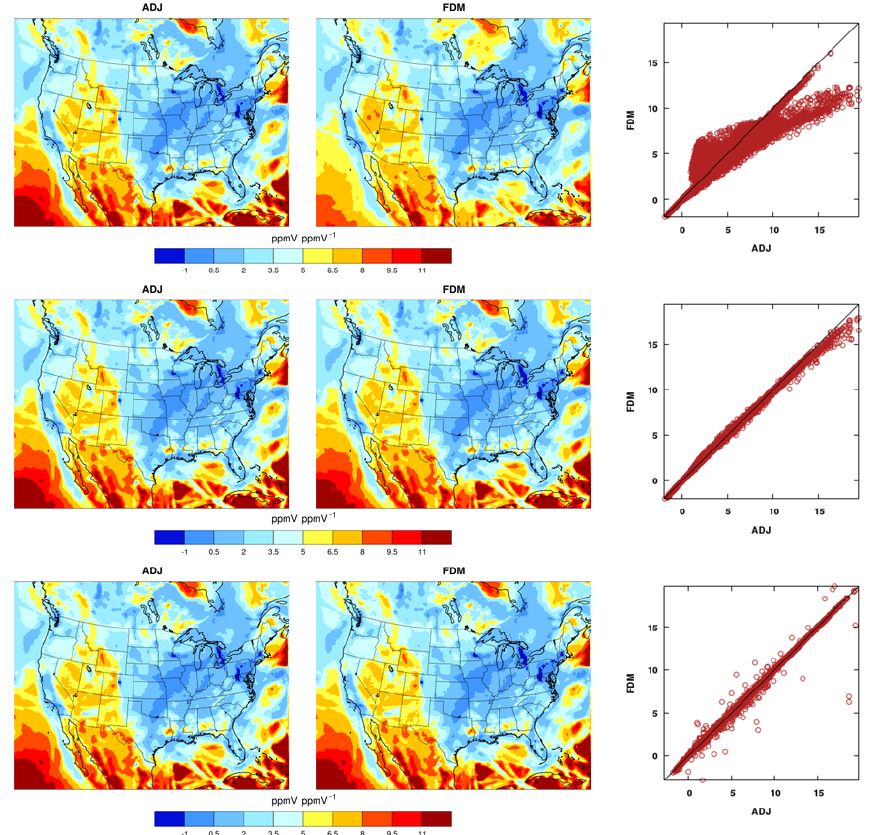
Figure 8. Evaluation of gas-phase chemistry with the ADJ (adjoint) against the FDM (finite-difference method) sensitivities of the final O 3 concentrations (ppmV) with respect to the initial NO 2 concentrations (ppmV) from a 1d test run. The perturbation sizes are 0.1, 0.01, and 0.001ppb for the FDM in the plots from the top to the